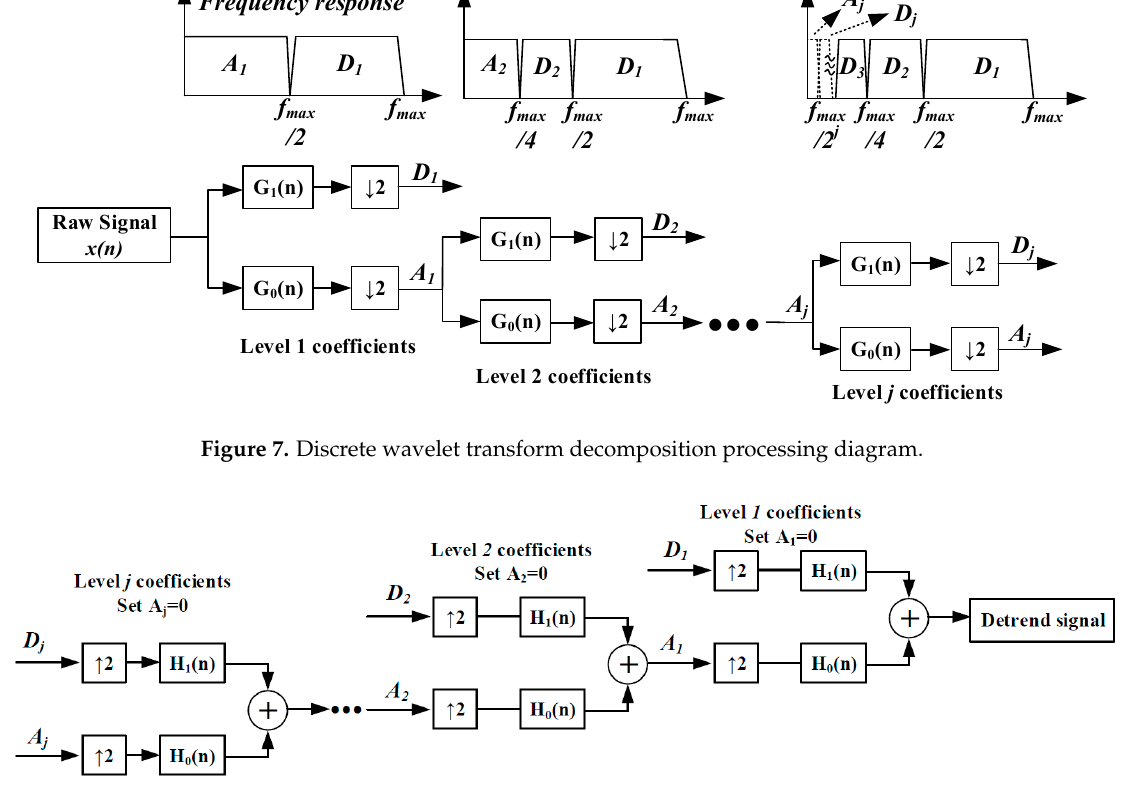
Figure 8. DWT-based reconstructed signal for drift elimination.